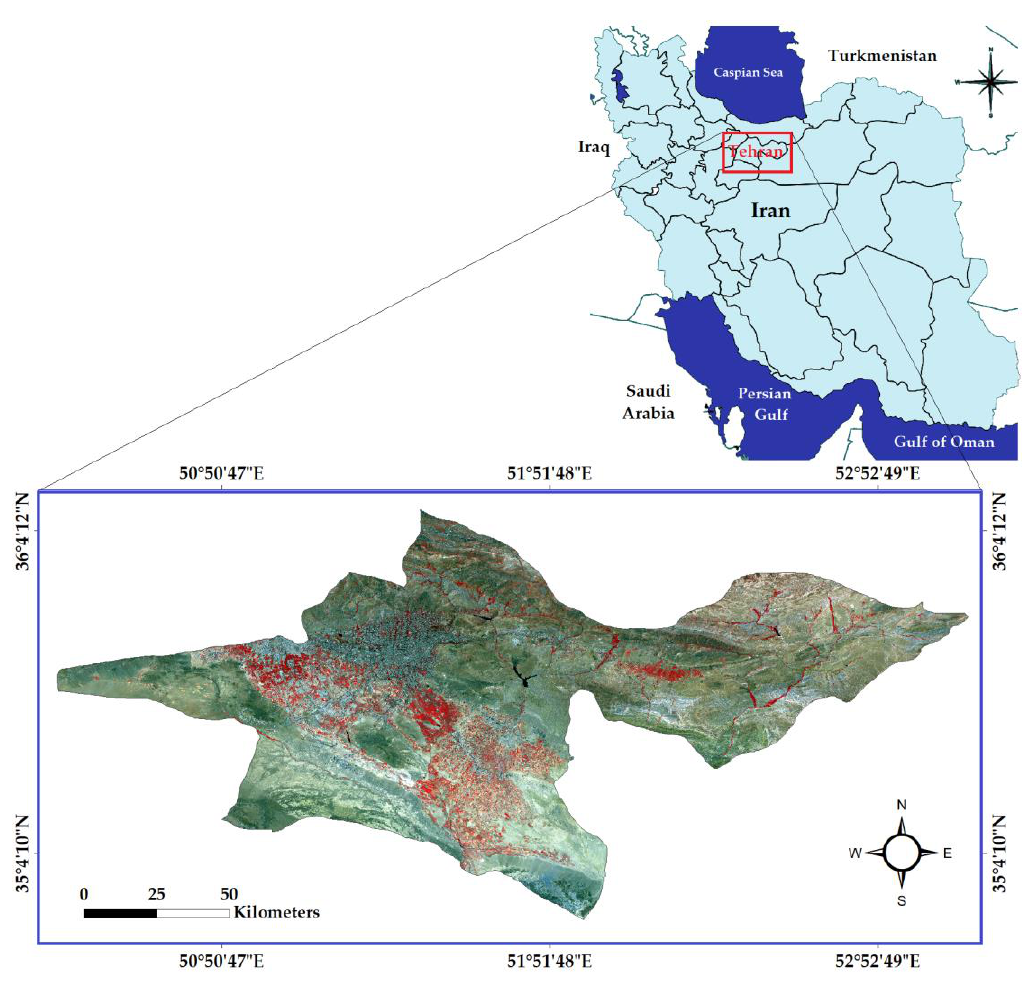
Figure 1. The geographic location of the Tehran Province. Blue box: the Sentinel-2 (S-2) false color composite of Tehran Province (NIR, red, green;